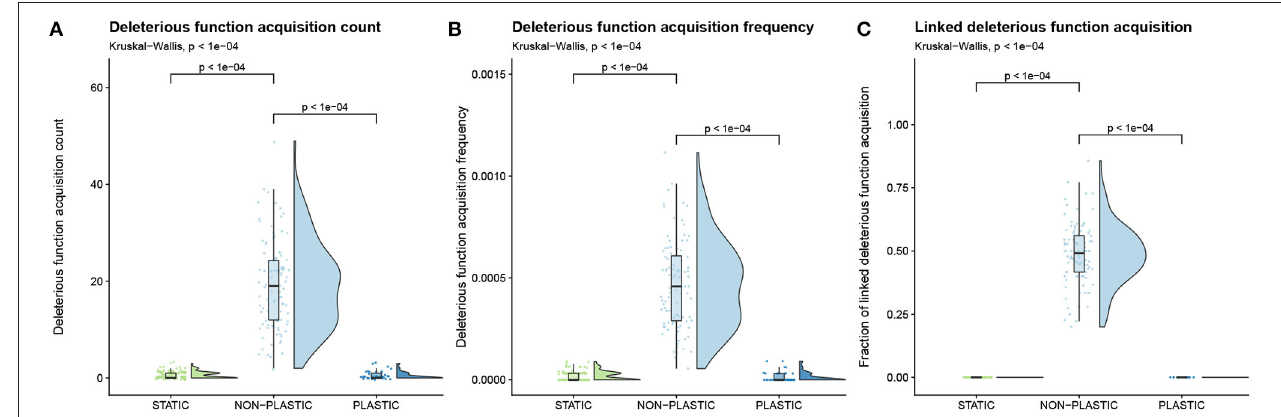
FIGURE 8 | Deleterious instruction accumulation. Raincloud plots of (A) deleterious function acquisition, (B) deleterious function acquisition frequency, and (C) the proportion of mutations that increase deleterious function expression along a lineage that co-occur with a change in phenotypic profile. Each plot is annotated with statistically significant comparisons (Bonferroni-corrected pairwise Wilcoxon rank-sum tests). Note that adaptive phenotypic plasticity evolved in 43 of 100 replicates from the PLASTIC treatment during phase one of this experiment; we used this more limited group to seed the 43 phase-two PLASTIC